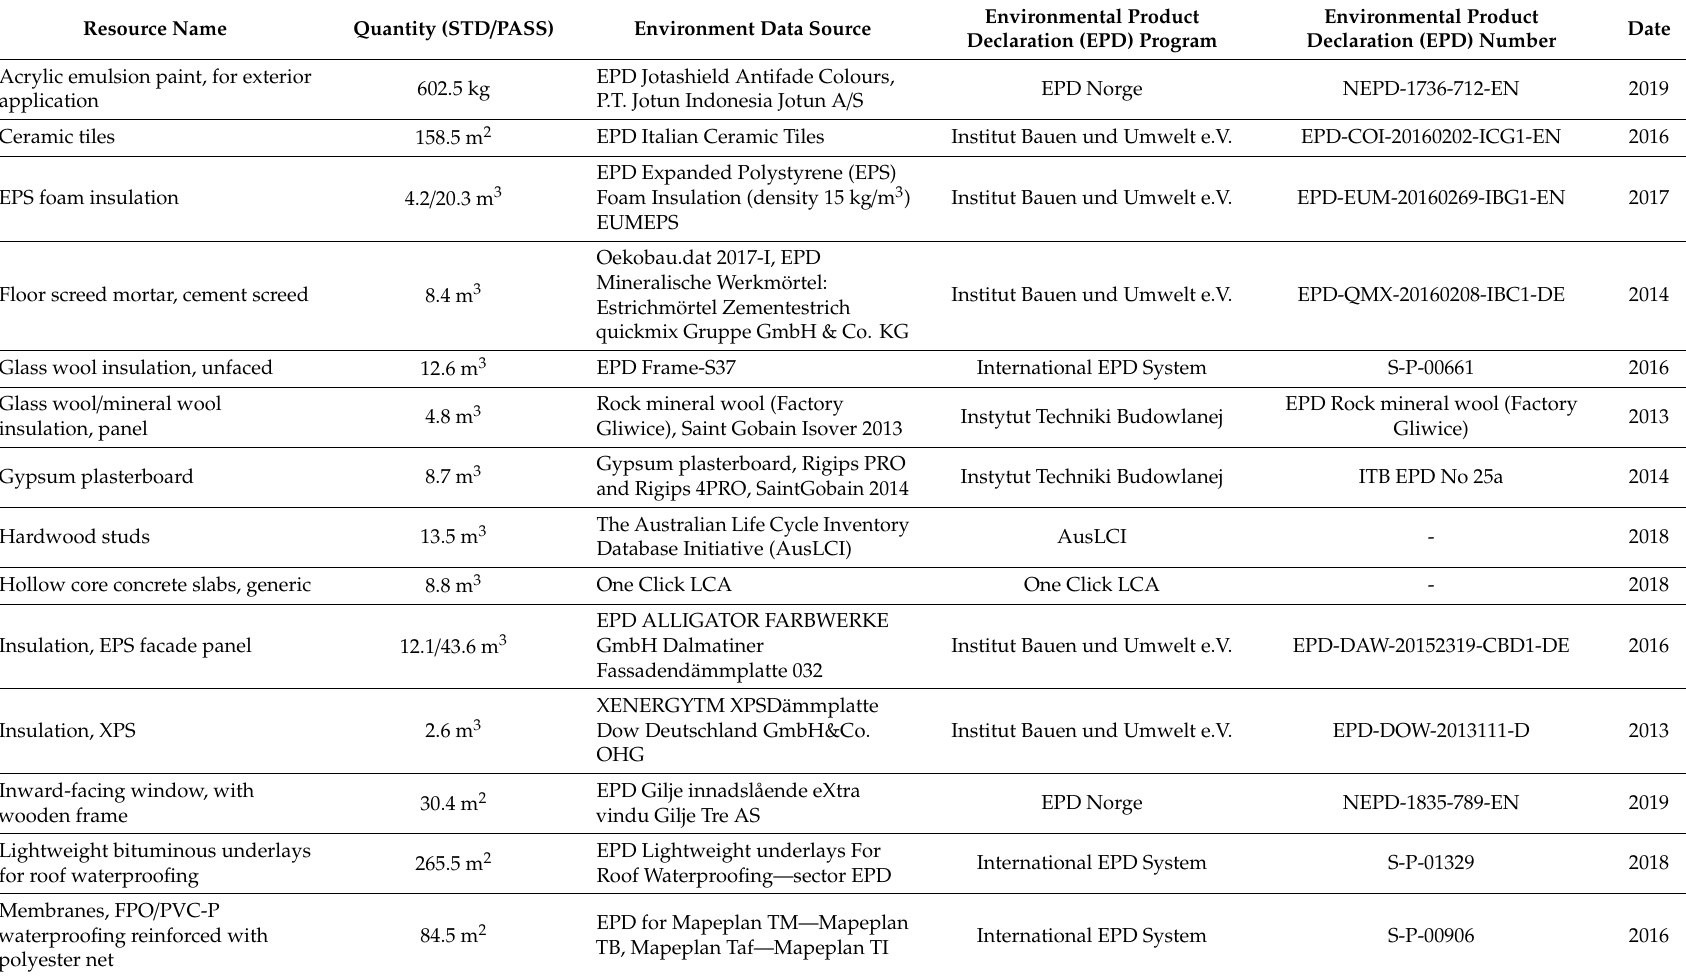
Table A2. The full data source for GWP calculation used in One Click LCA program—wood